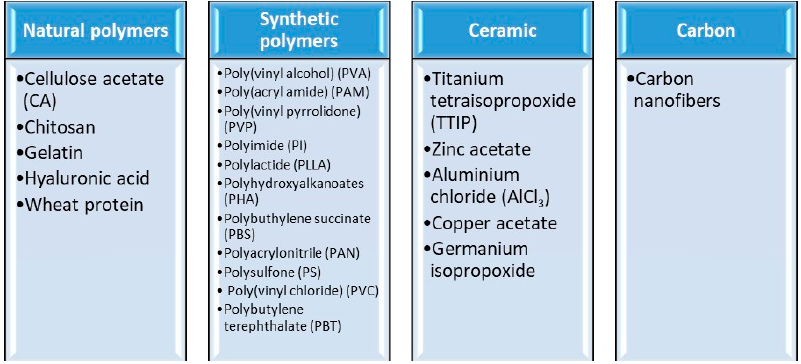
Figure 3. Main materials applied for the electrospinning process.